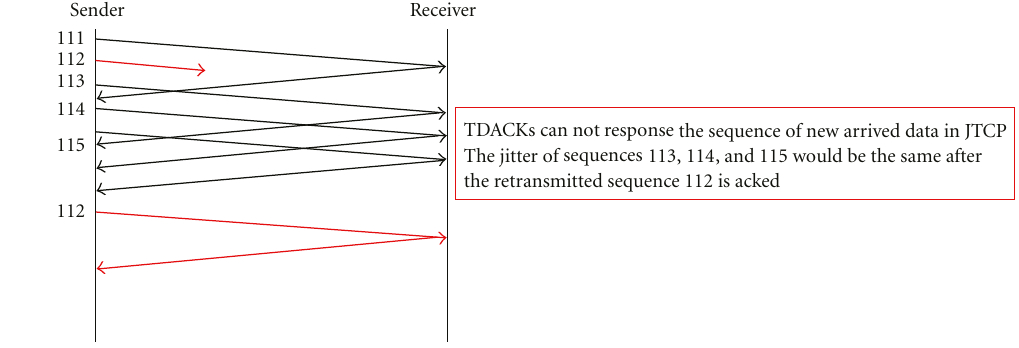
Figure 1: Problem of the receiving time stamps.